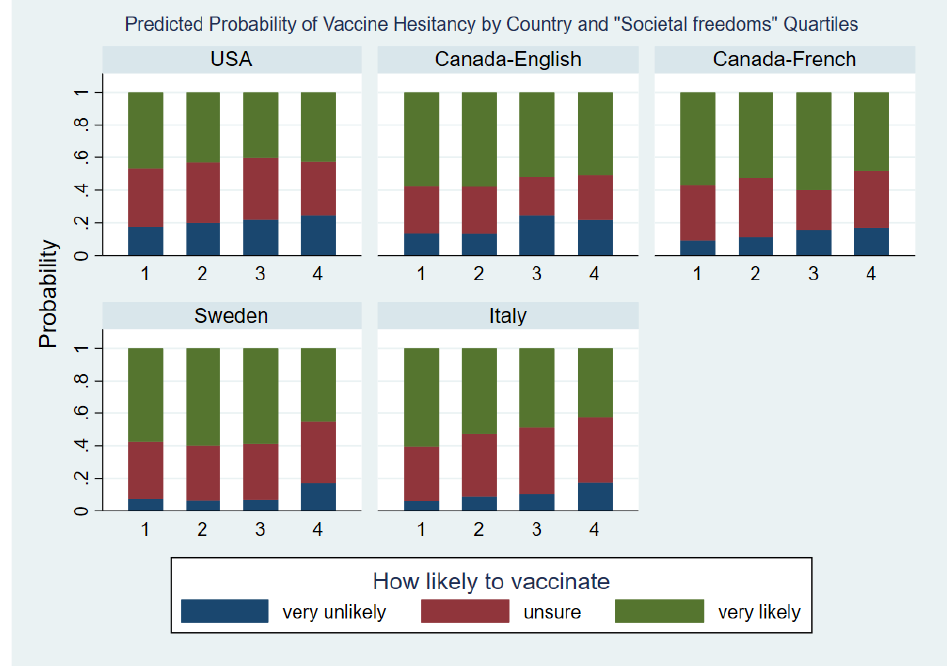
Figure 4. Predicted Probability of Vaccine Hesitancy by Country and “Societal freedoms” Quartiles.